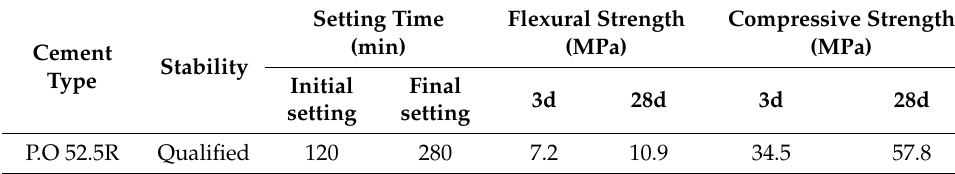
Table 1. Main performance parameters of P.O52.5R cement.